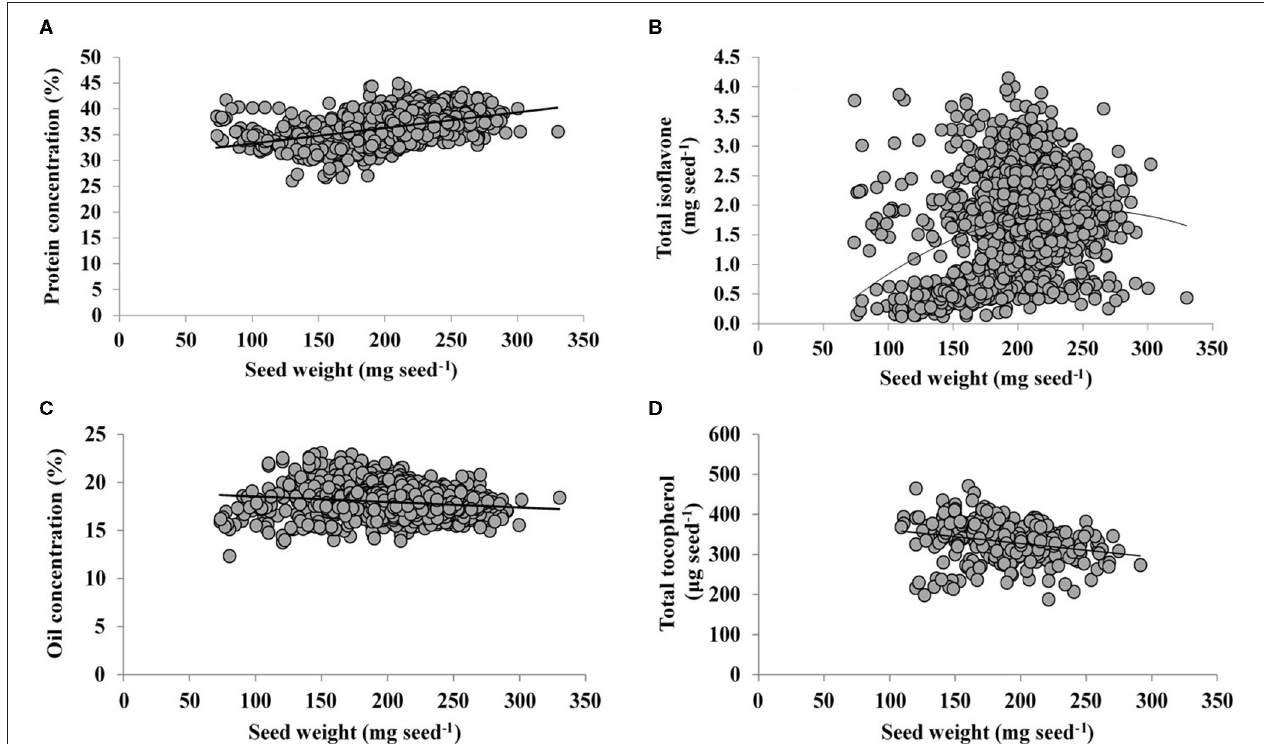
FIGURE 3 | Relationship of seed protein concentration (%, adjusted to 13% moisture content) (A) , total isoflavone (mg seed − 1 ) (B) , oil concentration (%, adjusted to 13% moisture content) (C) , and total tocopherol ( µ g seed − 1 ) with seed weight. The line represents a fitted linear model for samples from a range of soybean genotypes and environments. The following models were computed: (A) Y = 30.2 + 0.03 X , adjusted R 2 = 0.21, P < 0.0001; (B) Y = - 1.02 + 0.02 X − 5E-05 X 2 , adjusted R 2 = 0.08,